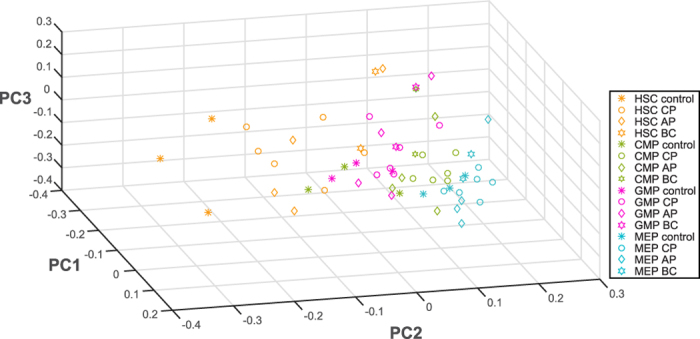
Separation of population-based and mechanistic effects using stem and progenitor cell data from primary CML patients.Genome-wide gene expression of 4 stem- and progenitor cell subpopulations (colours) across all phases of CML progression (shapes) in 12 patients and three healthy controls, represented by PCA-derived components 1, 2, and 3. PC: Principle Component, CP: chronic phase, AP: accelerated phase (by blast count criteria), APcyto: accelerated phase (by occurrence of additional clonal cytogenetic changes without increase in blast count), BC: blast crisis, HSC: hematopoietic stem cell, MEP: megakaryocyte-erythroid progenitor, GMP: granulocyte-macrophage progenitor, CMP: common myeloid progenitor. Data from GEO dataset GSE47927, by Copland M and Irvine DA22.